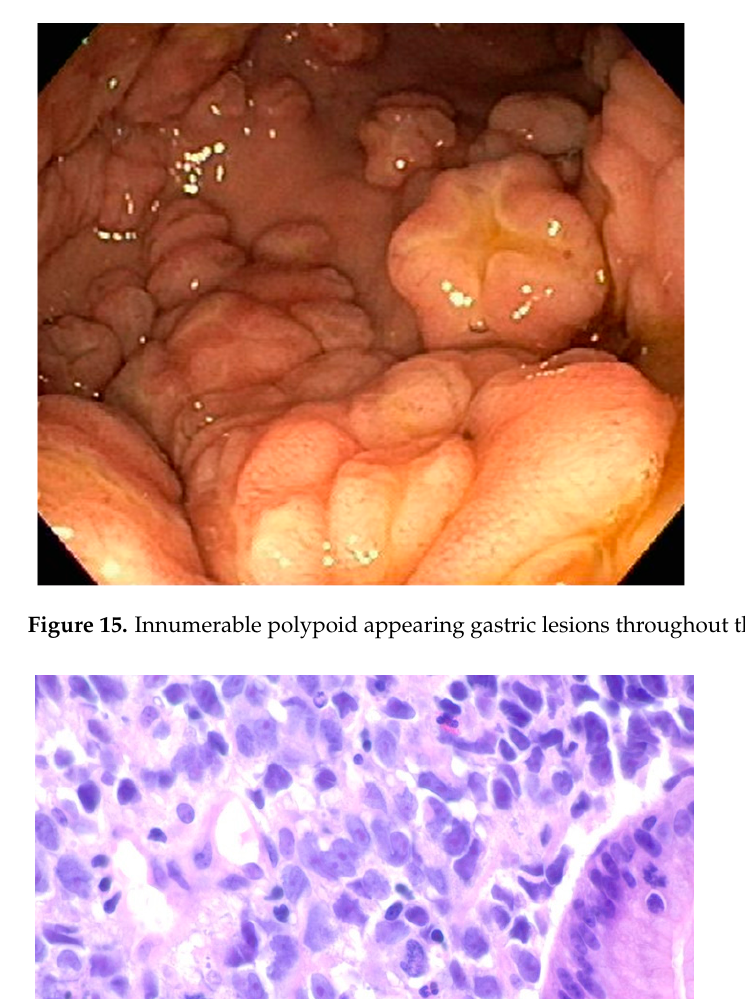
Figure 14. Large erosive mass noted on EGD about 22 cm from incisors.